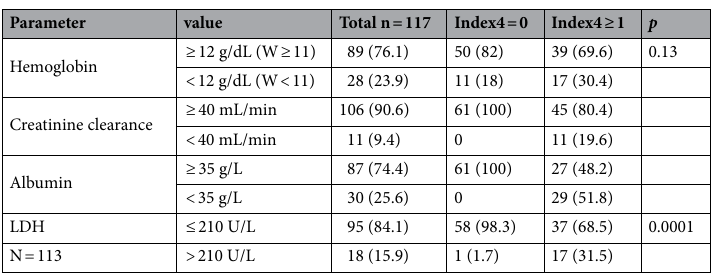
study was received by 34 patients (29.1%). Concomitant immunotherapy was included with the chemotherapy regimen in 6 patients (5.1%) and concomitant targeted therapies were given in 8 patients (6.8%). About one fourth of patients had lower hemoglobin (< 12 g/dL for men and < 11 g/dL for women) and hypoalbuminemia (Table 2). Low creatinine clearance (< 40 mL/min) and elevated LDH were observed in 9.4% and 15.9% of patients in the cohort, respectively. Sixty-one patients (52.1%) had an Index4 score of 0, defined as all of the following: ECOG PS 0 or 1, creatinine clearance above 40 mL/min, albumin above 35 g/L and stage 1 to 3 cancer. The remaining 56 patients (47.9%) had an Index4 score above 0. Twenty-eight patients had an Index4 score of 1, 15 patients had a score of 2 and 13 patients had an Index4 score of 3 (Fig. 1). No patients had a score of 4. The two groups of patients with Index4 above 0 and Index4 of 0 had no significant differences in mean age, proportion of patients above age 75 years old or gender (Table 1). Breast, gynecologic and genitourinary cancers were more prevalent in the Index4 score 0 group, while gastrointestinal and lung cancers were more prevalent in the group with Index4 score of 1 or higher. Patients in the Index4 score 0 group received more frequently radiation therapy during the study (37.7% of cases) than patients in the Index4 score of 1 or higher group, who received radiation in 19.6% of cases (Fisher’s exact test p = 0.04, Table 1).